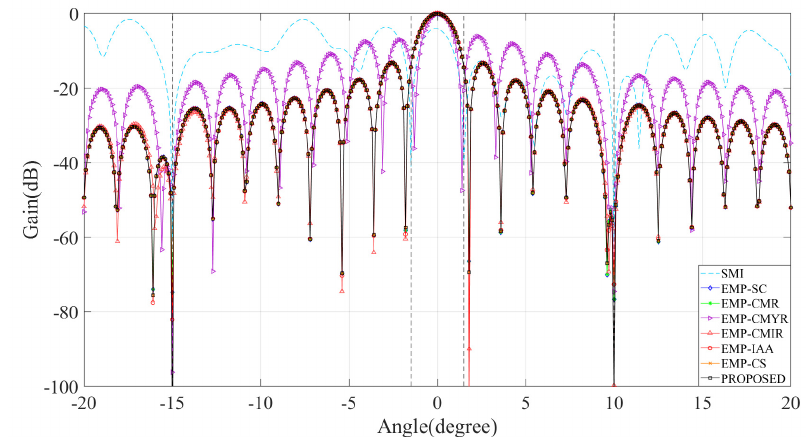
Figure 2. Comparison of beam pattern.